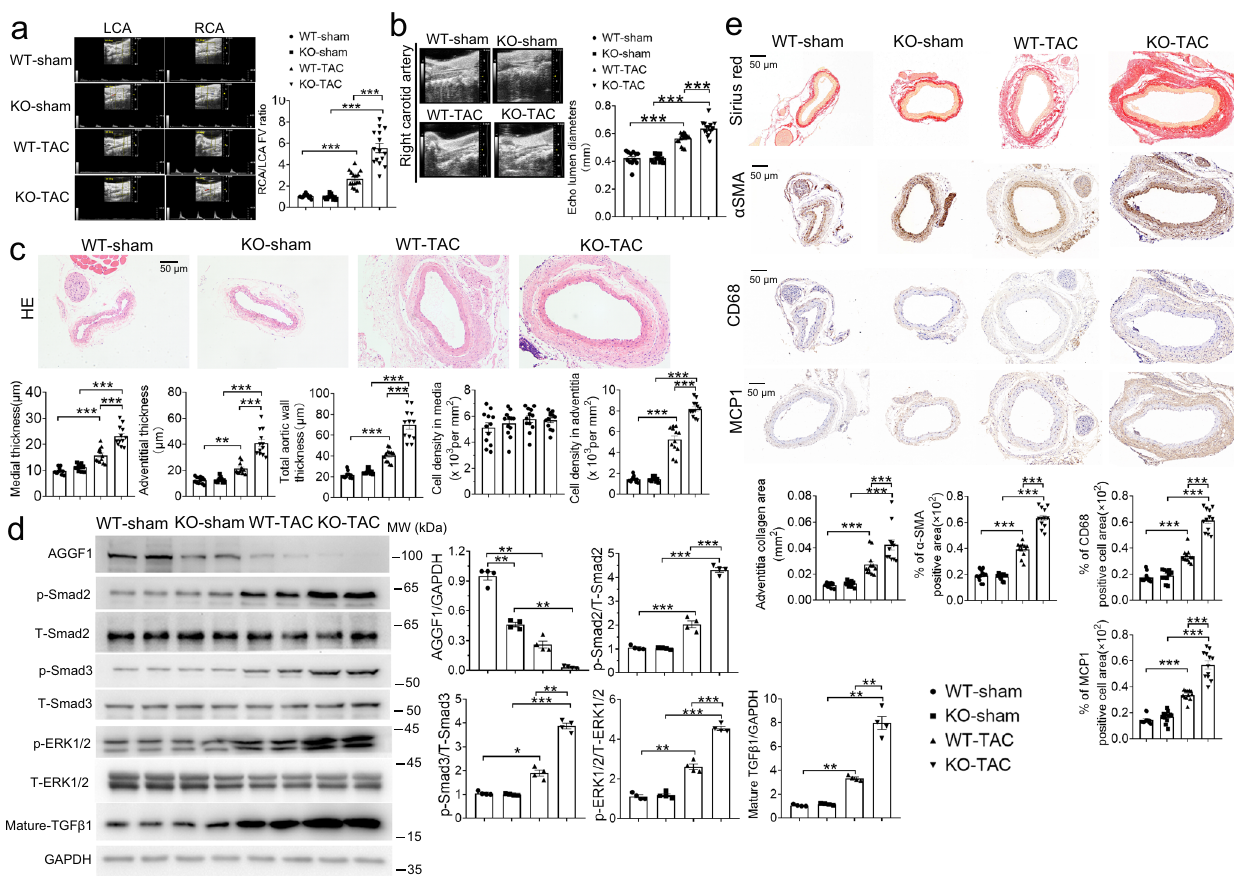
Fig. 1 | Aggf1 haploinsuf fi ciency aggravates TAC-induced arterial dilatation, remodeling,andin fl ammationinmalemice.a EchocardiographicimagesofLCA and RCA from Aggf1 +/+ (WT) or Aggf1 +/ − (KO) mice three weeks after TAC or sham operation.Thebargraphontherightshowstheratio ofblood fl owvelocity(FV)of RCAoverLCA( n =12, 12, 15,and15mice). b Meanlumendiameterof RCAfromWT or KO mice ( n =12, 12, 15, and 15 mice). c H&E staining of cross-sections of RCA ( n =12 mice/group). Bar graphs show medial thickness (1st graph), adventitial thickness (2nd graph), total aortic wall thickness (3rd graph), cell density in media (4th graph), and cell density in adventitia (5th graph). d Western blot analysis was carried out for AGGF1, phosphorylated ERK1/2 (p-ERK1/2), total ERK1/2 (T-ERK1/2),